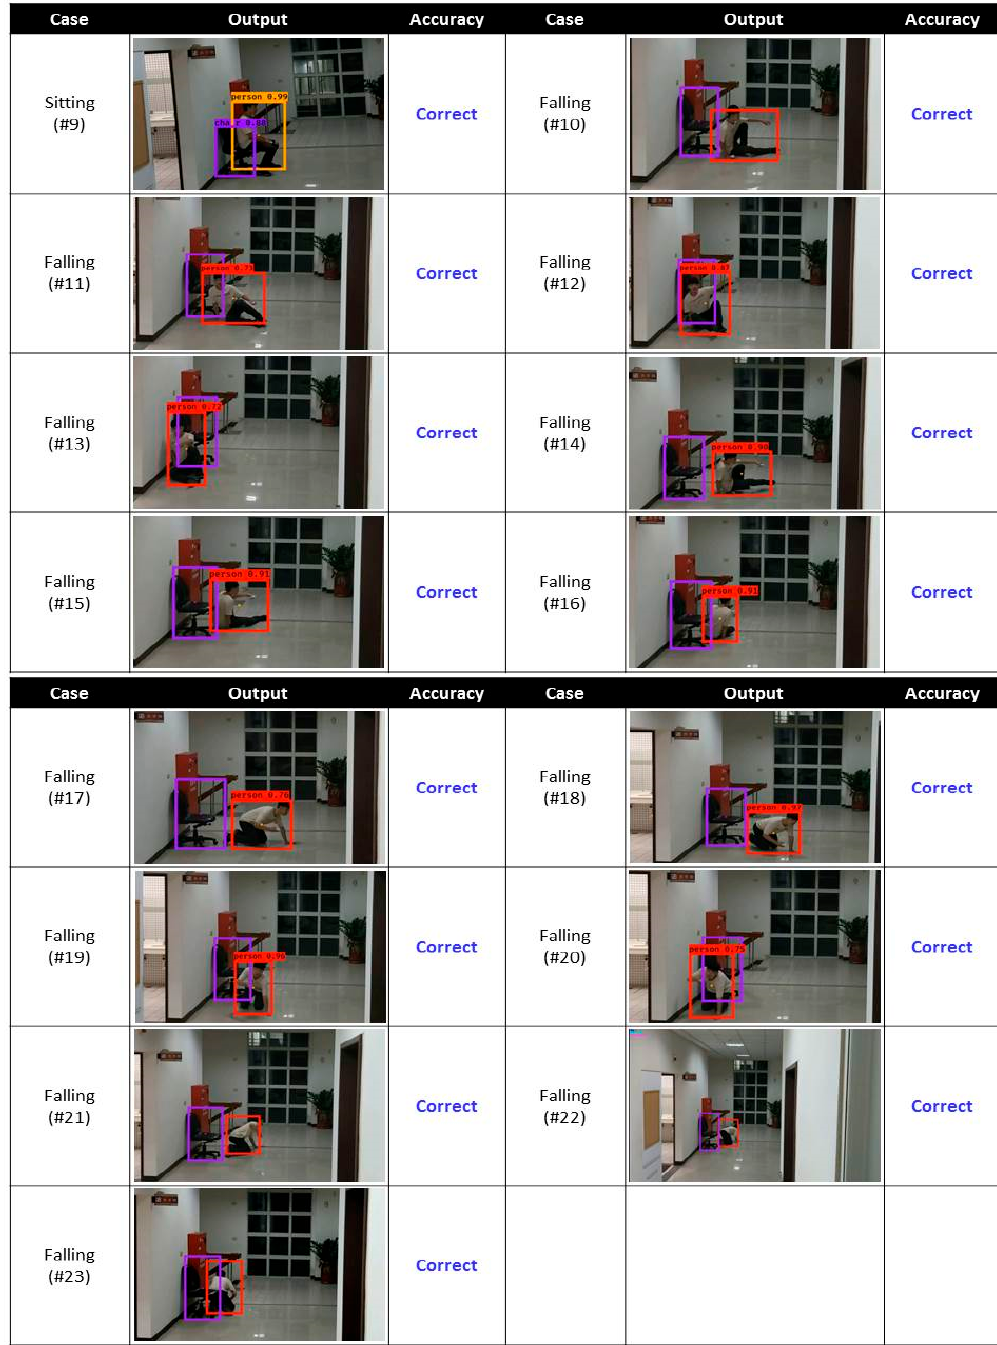
Figure 10. The results of the common situation test cases.